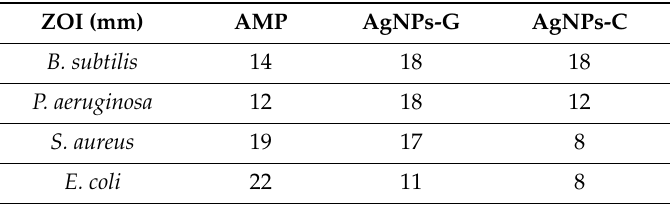
Table 1. Antibacterial activity study outcome of AgNPs-G.